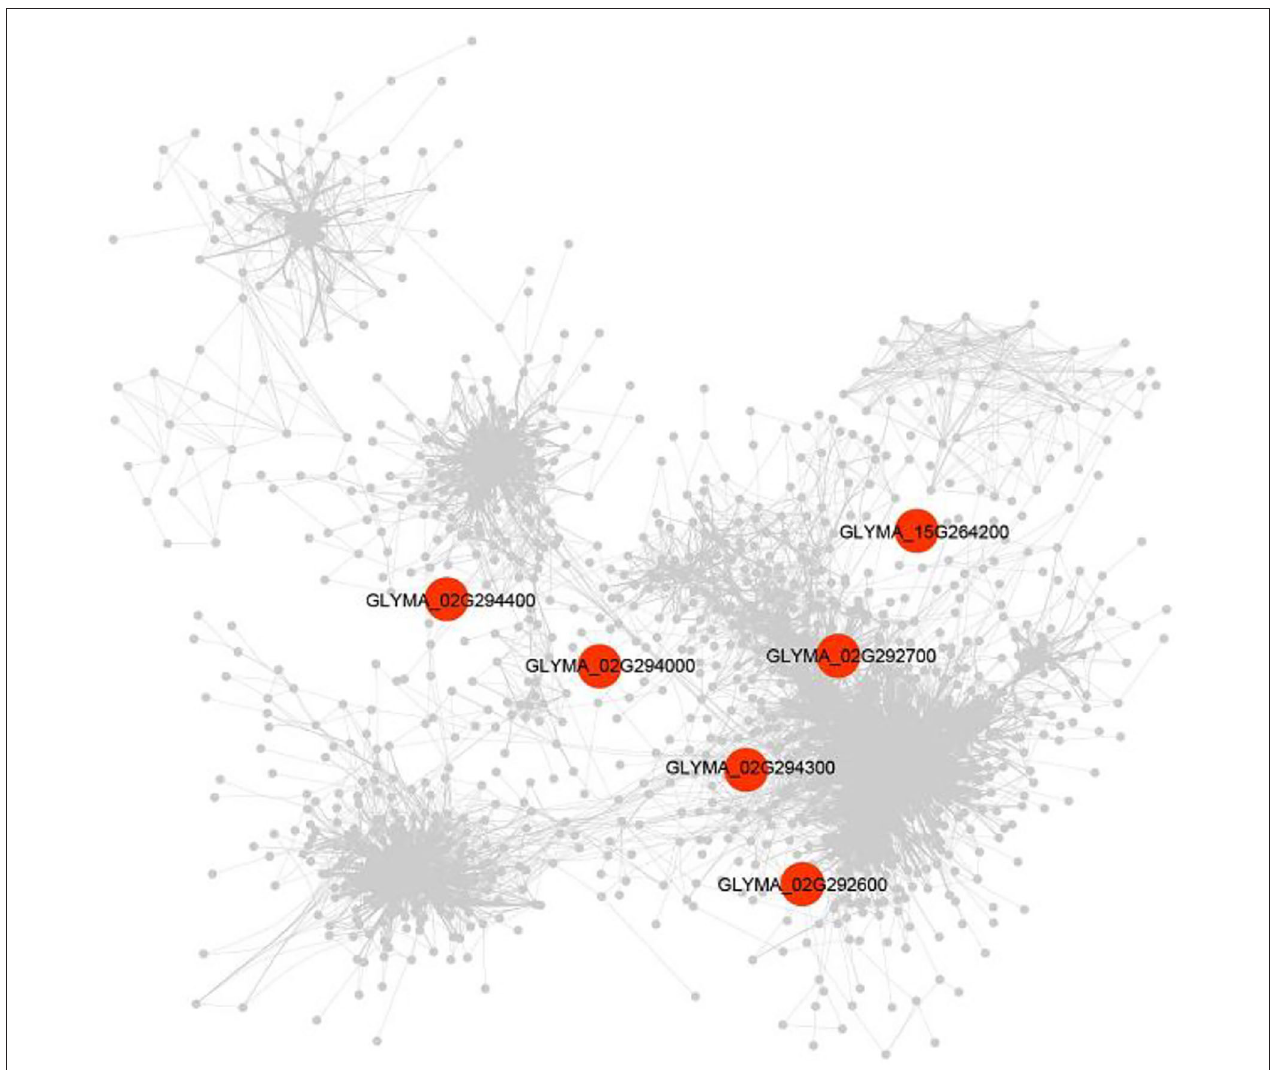
FIGURE 7 | A gene co-expression network underlying soluble sugar content. The co-expression was performed with transcriptome data under high- vs. low-soluble sugar content ( n = 1,515). Red shapes represent the genes that were detected by GWAS. Glyma.02G294400 , and Glyma.15G264200 genes were discovered to be correlated with 53, 4, 1, and 1 genes, respectively ( Supplementary Table S6